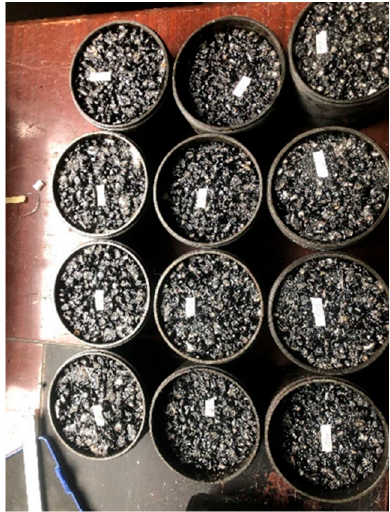
Figure 4. Marshall test specimens.